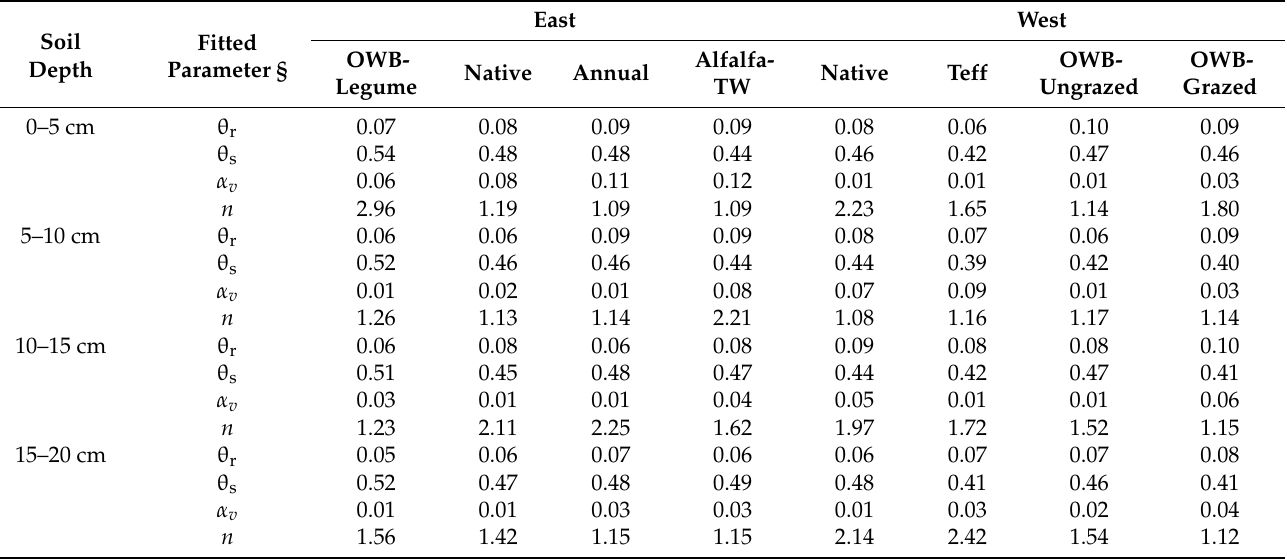
Table 2. Estimated van Genuchten model parameter values obtained from the simultaneous fits of the measured soil water retention curves (SWRCs) data to Equation (3) for all treatments in the east and west pasture area during a 2-year study period